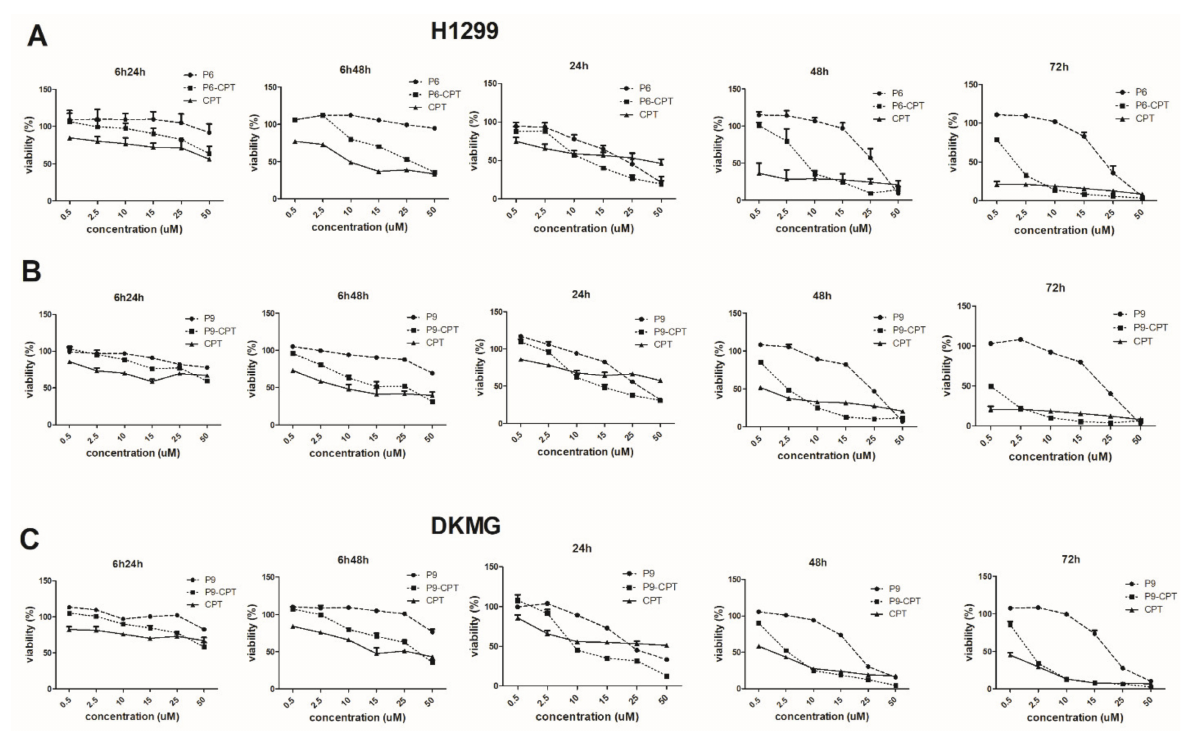
Figure 9. Analysis of cytotoxicity of the P6, P6-CPT, P9, P9-CPT, and CPT. ( A ) H1299 P6, ( B ) H1299 P9, and ( C ) DKMG P9 cells were cultured in a 96-well plate with six different concentrations of peptides, peptide conjugates, or CPT for 24, 48, and 72 h in two different protocols. The cell viability was measured by the XTT assay. Viability of the control non-treated cells was used as 100%. The viability of treated cells was represented as percentages of the control. Data are shown as Mean ±